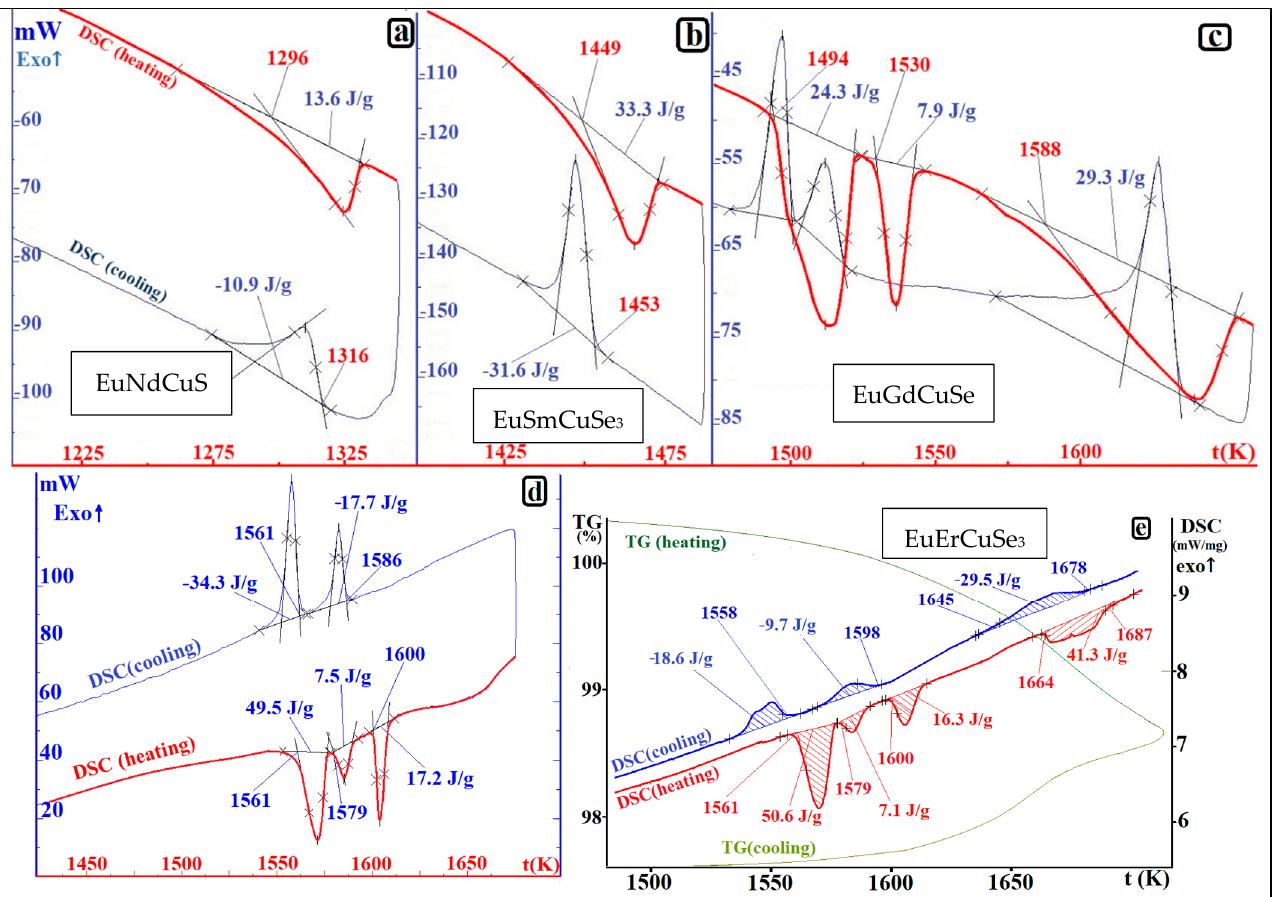
Figure 7. Thermograms of EuLnCuSe 3 (Ln-Nd, Sm, Gd, Er) samples. ( a – e )—SC/t dependences of SETARAM SETSYS Evolution for samples ( a )—EuNdCuSe 3 , ( b )—EuSmCuSe 3 , ( c )—EuGdCuSe 3 . ( d )—EuErCuSe 3 weighing 40–105 mg, which were in evacuated sealed quartz ampoules. ( e )—Netzsch DSC/TG/t dependence of EuErCuSe 3 , sample weight 76.9 mg. was in an open graphite crucible G-8.